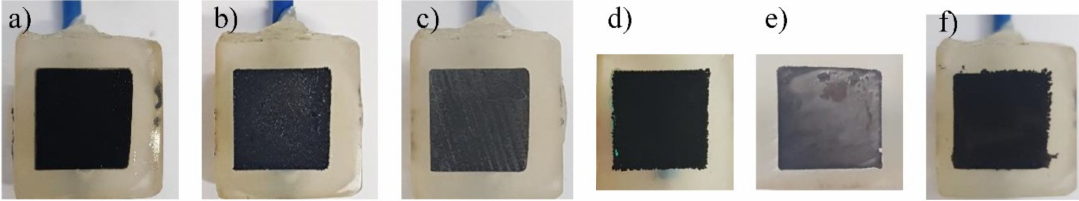
Figure 5. Ni samples (1 × 1 cm 2 , embedded in insulating epoxy matrix) after polarization tests in: ( a ) bath 1, ( b ) bath 2, ( c ) bath 3, ( d ) bath 4, ( e ) bath 5, ( f ) bath